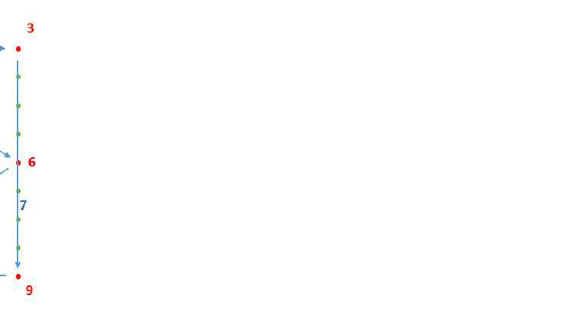
Figure 11. Turning points (with running number) and movement directions of the dot in the smooth pursuit task. Table 5. Description of the time periods.